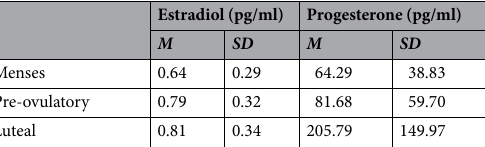
Table 1. Mean levels of salivary estradiol and progesterone in each cycle phase. N = 36. M = Mean; SD = Standard